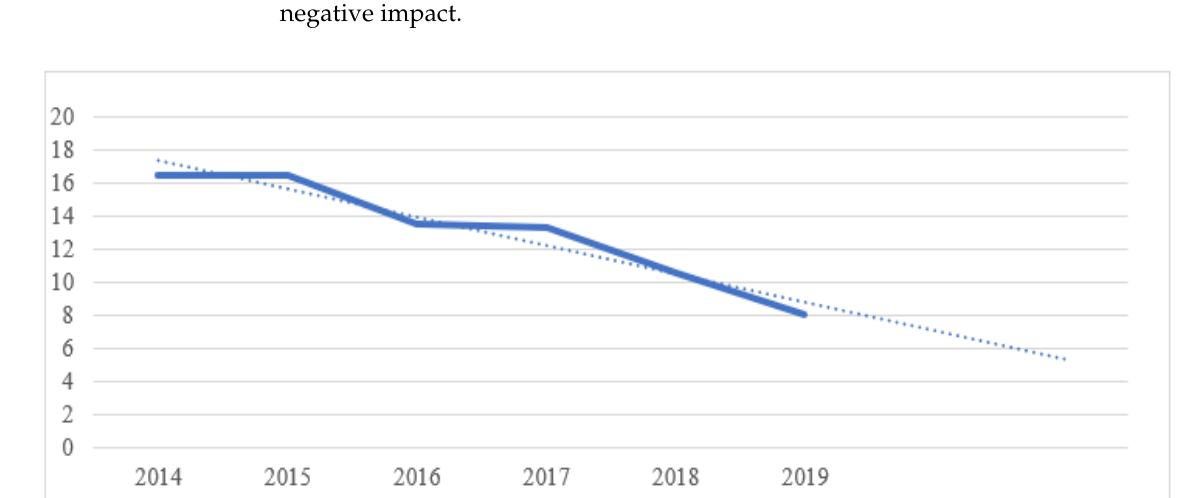
Table 3. Results of using two paired samples in the means T-test for H3 verification.